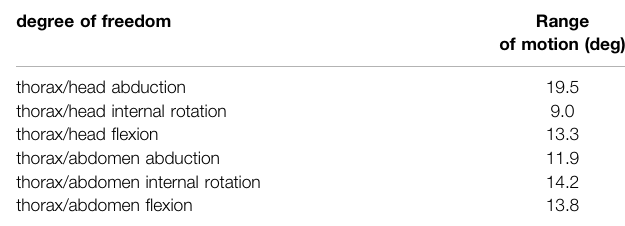
TABLE3| Resultsoftheinversekinematicsimulationforthetrunkjoints.Reported values represent the range of motion in degrees of the joint angles. degree of